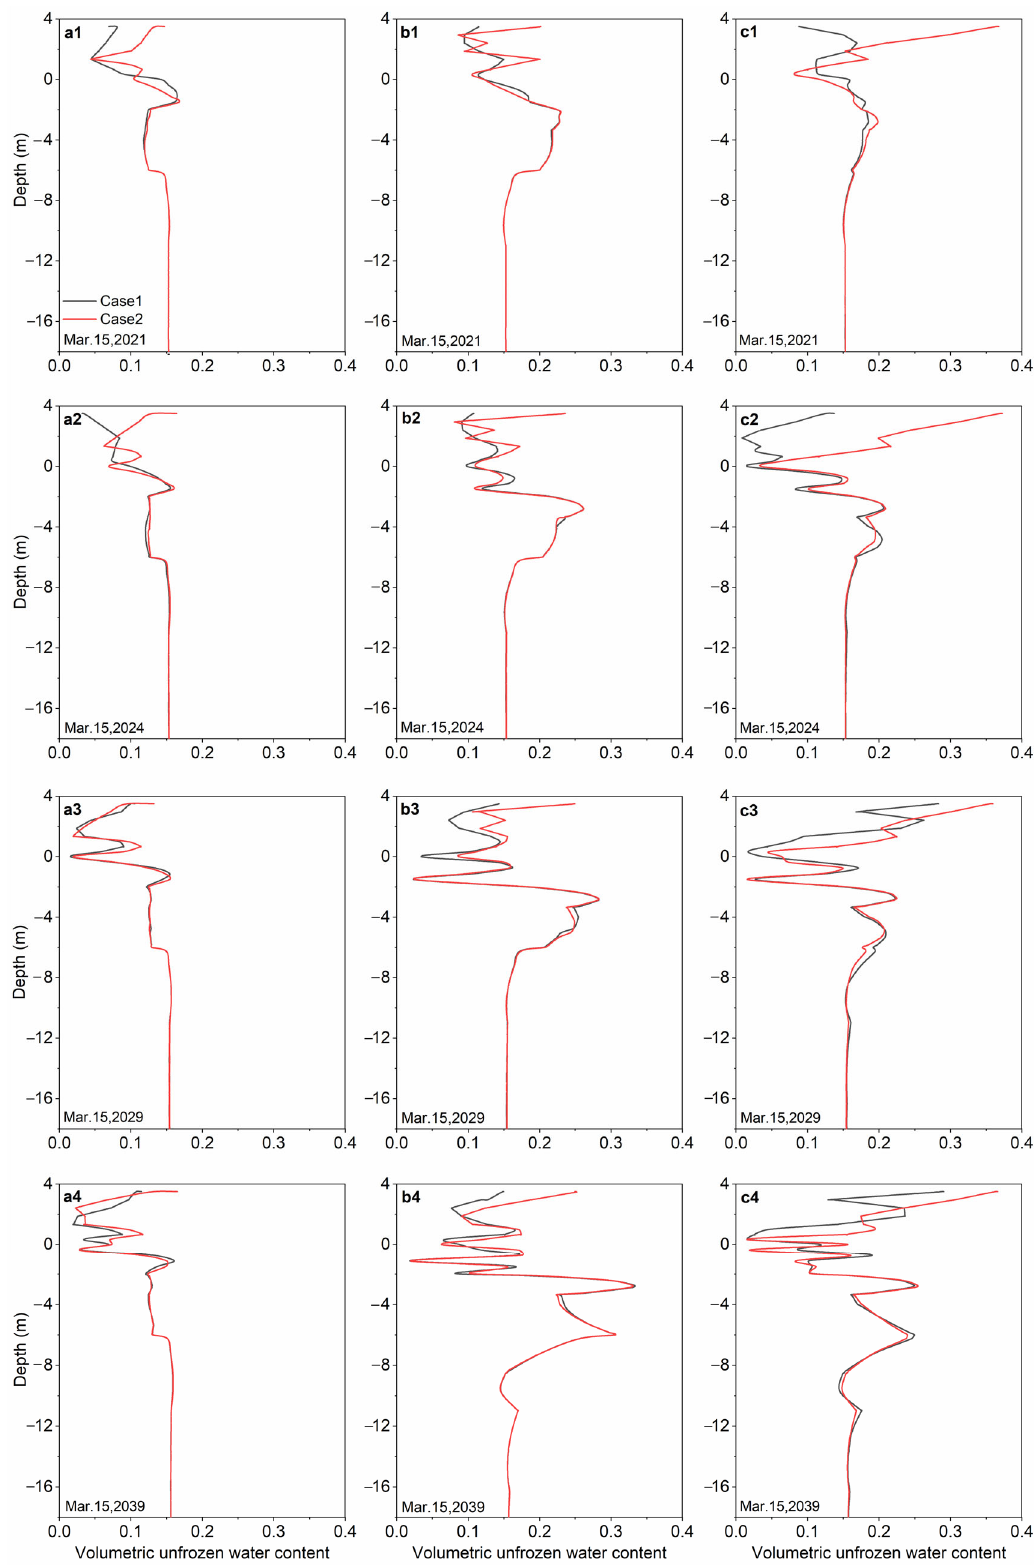
Figure 15. Comparison of the vertical distributions of volumetric liquid water contents under the road centerlines in Case 1 and Case 2 on March 15 of different years for the three subgrade structures: ( a1 – a4 ) replacement block–stone subgrade structure, ( b1 – b4 ) replacement breccia subgrade structure, and ( c1 – c4 ) replacement gravel subgrade structure.